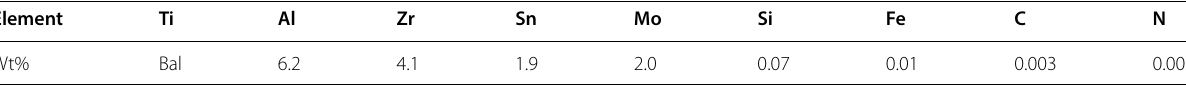
Table 1 Nominal chemical composition of TA19 (wt%) Element